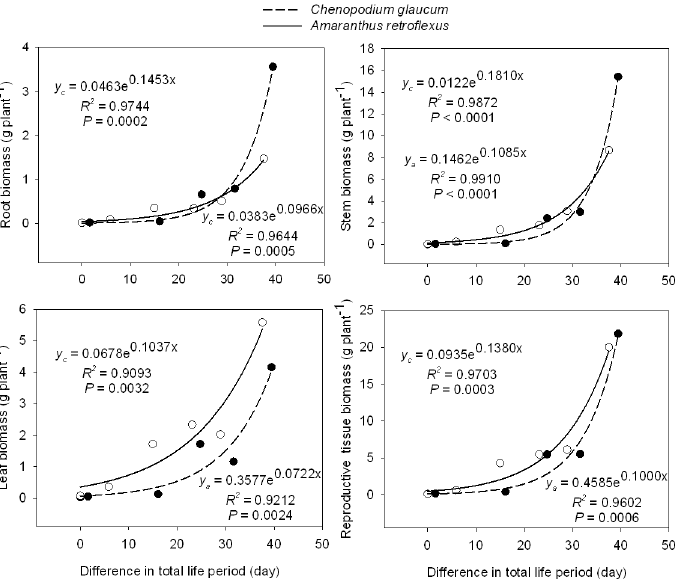
Fig 3. Biomass of various tissue groups of Chenopodium glaucum (y c ) and Amaranthus retroflexus (y a ) in relation to the difference in total life period (difference between life period of any given treatment and life period of last sowing date